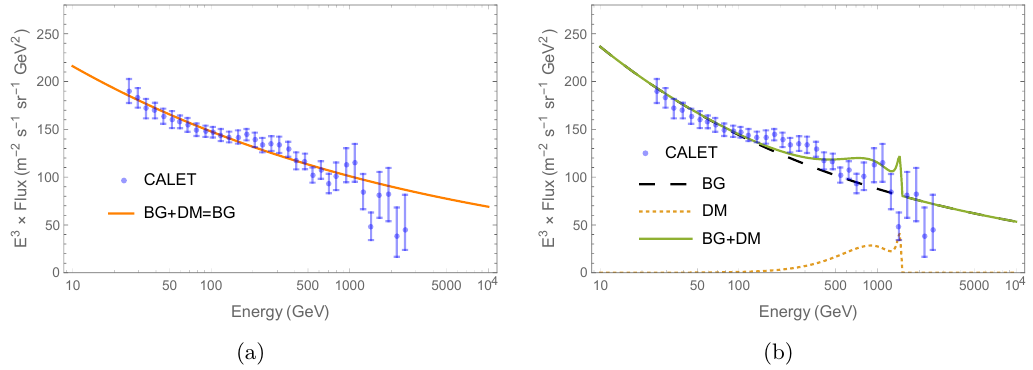
Figure 6 . Cosmic ray electron spectrum (multiplied by E 3 ). In both figures, the blue points with error bars are the flux measured by CALET. (a) The combined case. The solid orange line shows the best-fitting spectrum. It does not support contributions from the DM. The fitting quality is χ 2 / d.o.f. = 33 . 6 / 35 . (b) The h σv i -fixed case. In the figure, it is presupposed that m φ = 1 . 5 TeV, h σv i = 1 . 8 × 10 − 26 cm 3 / s, h σv i = 3 . 6 × 10 − 25 cm 3 / s. The φ,φ → η → e + ,e − φ,φ → η → µ + ,µ − dashed line shows the best-fitting cosmic electron background (BG). The fitting parameters are, F BG = C [ E/ (100 GeV )] − α with C = 1 . 44 × 10 − 4 ( GeV m 2 s sr ) − 1 and α = 3 . 22 , The fitting quality is χ 2 / d.o.f. = 67 . 2 / 37 . The dotted line shows the flux contributed by DM. The solid line represents the total